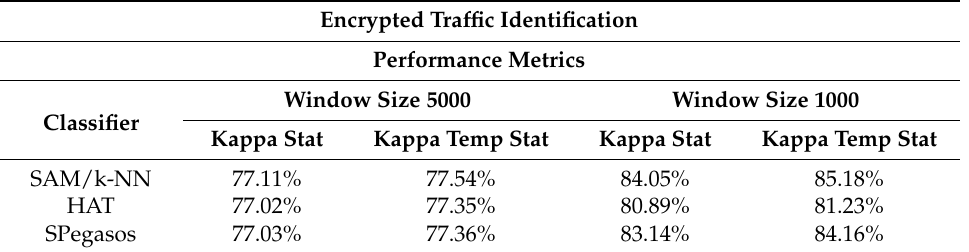
Table 10. Comparison between